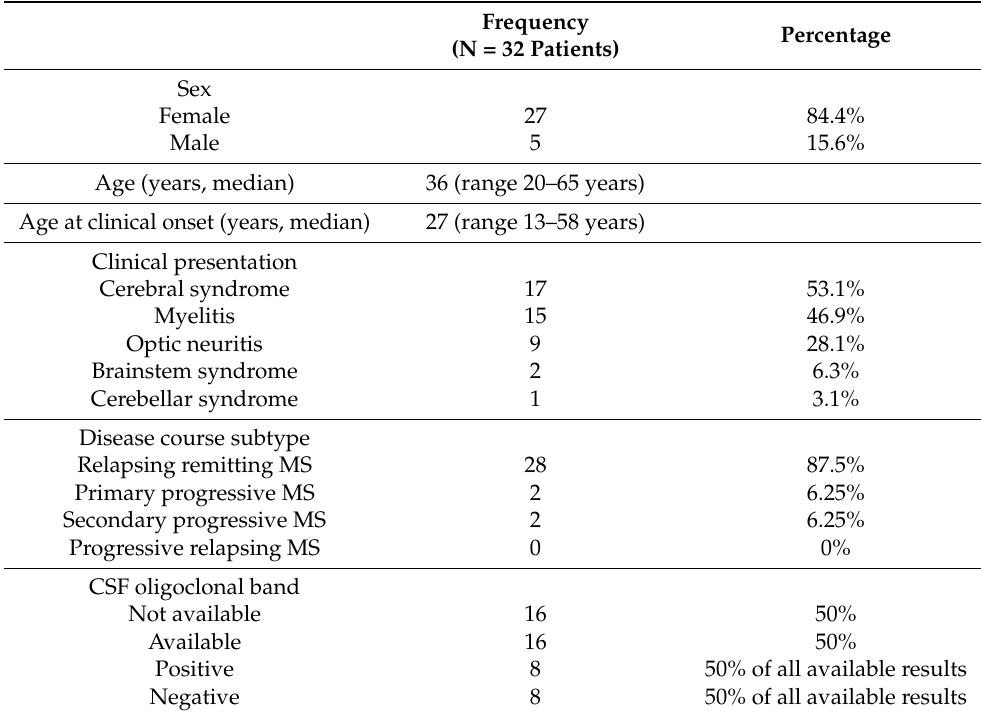
Table 1. Demographic data, clinical presentation, and laboratory